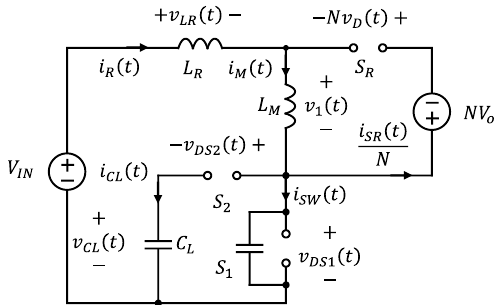
Figure 10. Equivalent circuit in state 5. Figure 11. Equivalent circuit in state 6. Figure 11. Equivalent circuit in state